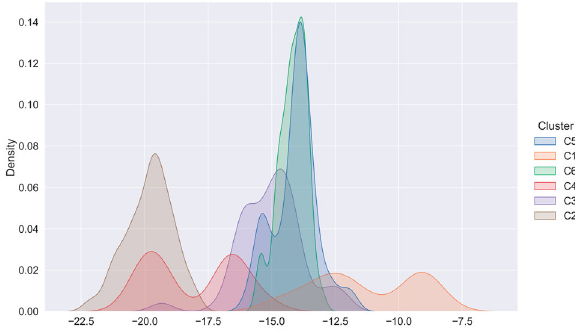
Fig. 5 Arrhenius slopes distributed according to k means clustering. Distribution of Arrhenius slopes according to k means clustering of the t-SNE two-dimensional projection of alloy composition